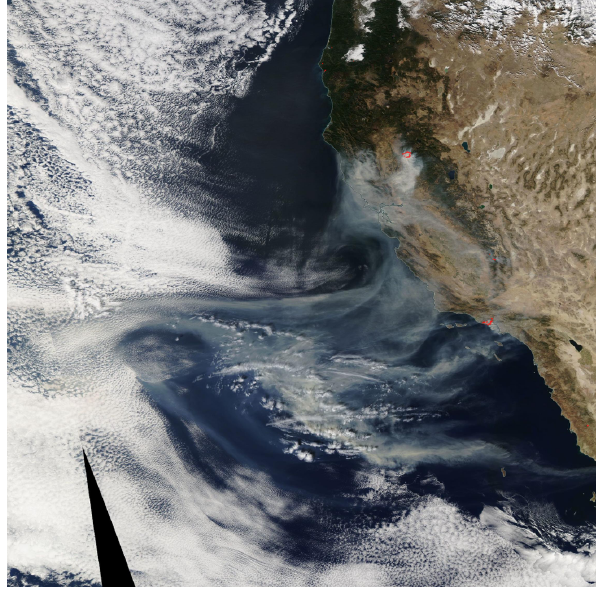
Figure A3. Smoke plume captured by Aqua MODIS for the Califor- nian fire event on 10 November 2018 (source: https://gibs.earthdata. nasa.gov, last access: 7 August 2019). The red regions indicate fires and thermal